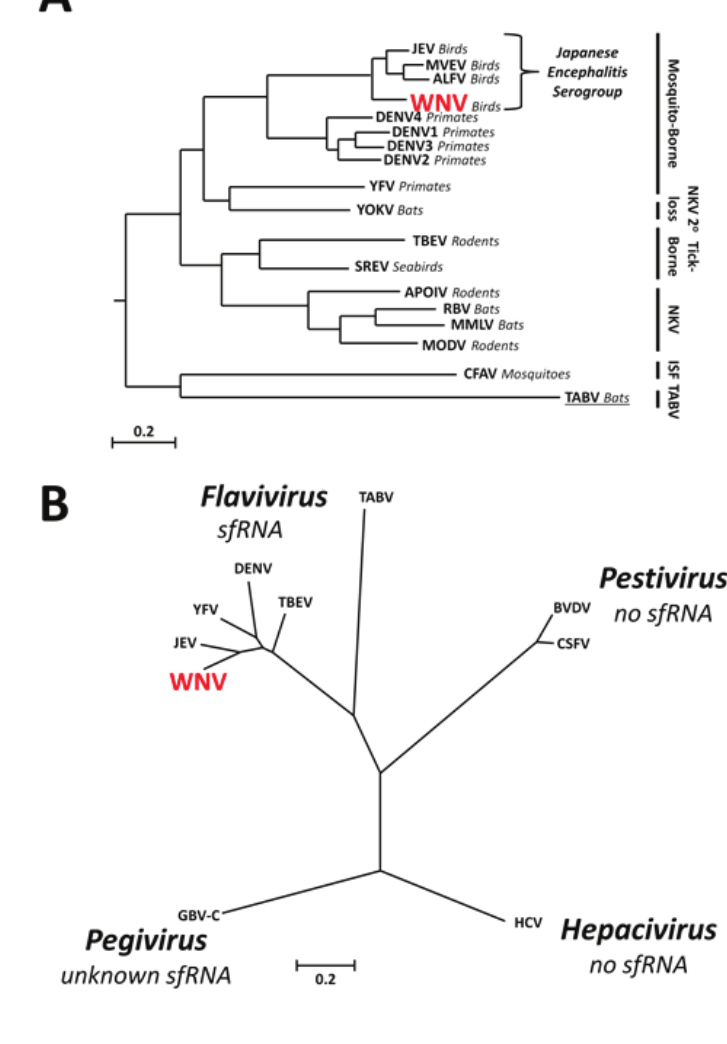
Figure 1. Phylogenetic relationships and sfRNA production within the genus Flavivirus and the family Flaviviridae. ( A ) Phylogenetic tree demonstrating the evolutionary relationships between flaviviruses characterised for sfRNA production and basal Tamana bat virus (TABV) which remains uncharacterised (underlined). The tree was generated using the amino acid sequence of the entire genomic polyproteins. Vector classes for virus groups are indicated by black bars to the right of the tree. Primary vertebrate hosts are indicated in italics (other than for ISFs). Bar = 0.2 substitutions per site. ISF = insect-specific flavivirus; NKV = no known vector. Modified from Cook et al. , 2012 and Kitchen et al. , 2011 [5,6]; ( B ) sfRNA does not appear to be produced by other genera ( Hepacivirus , Pestivirus ) within the family Flaviviridae. The proposed genus Pegivirus remains uncharacterised for sfRNA production. Phylogenetic tree generated using the amino acid sequences of viral RNA-dependant RNA polymerases. Bar = 0.2 substitutions per site. Modified from Stapleton et al. , 2011